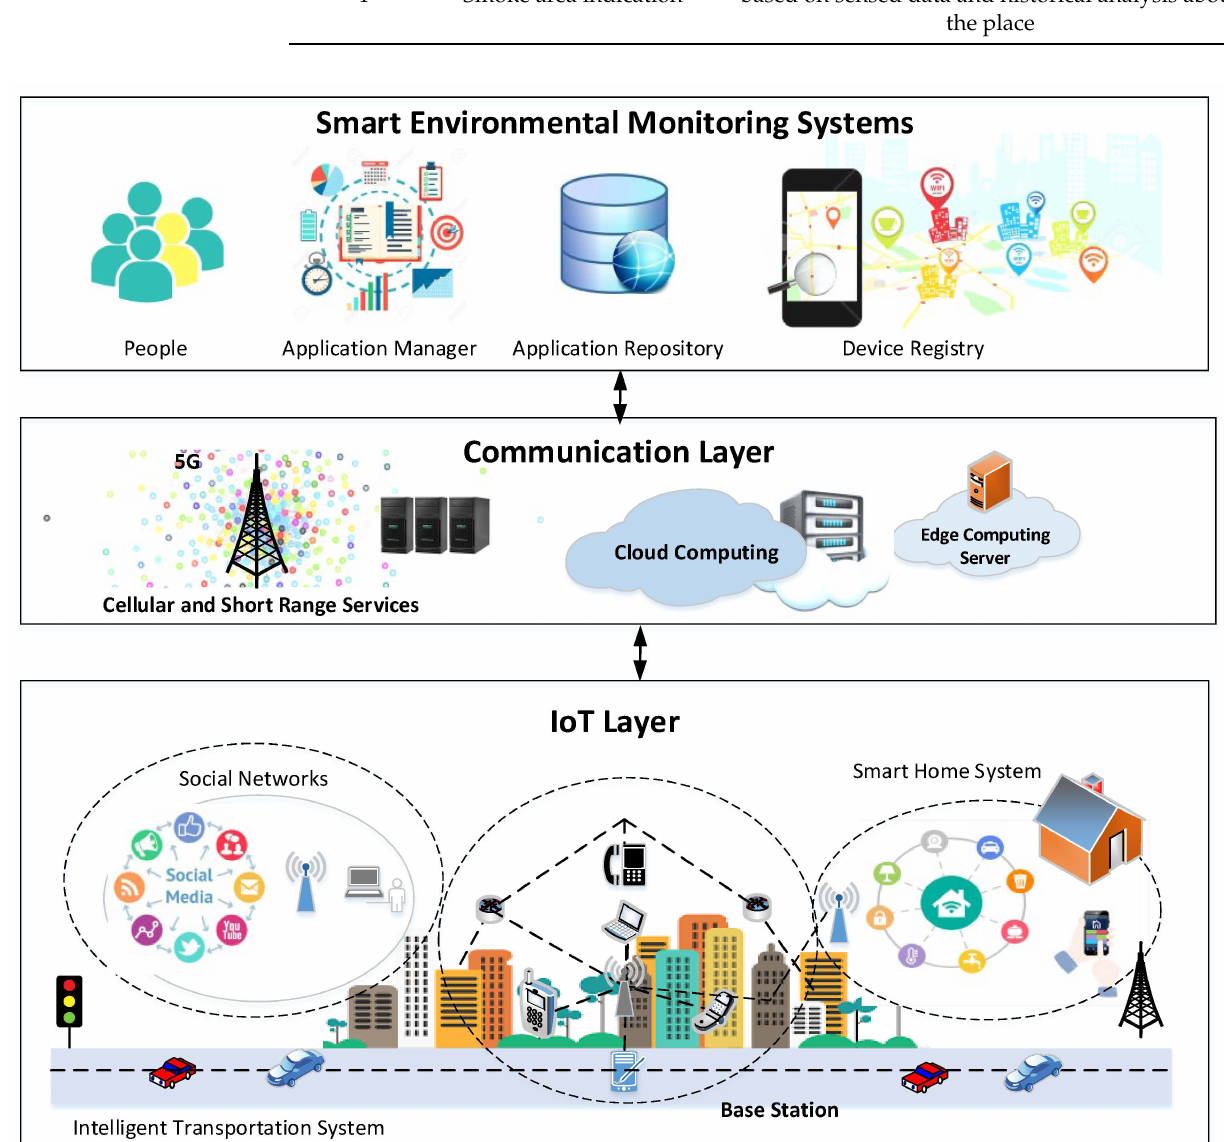
Figure 2. Proposed self-organizing IoT